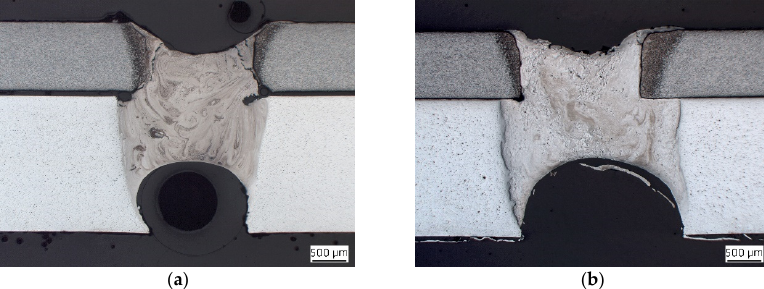
Figure 19. Comparison between the results of the displacement process at 1936 W magnet power after 100 ms ( a ) and 200 ms ( b ). 100 ms ( a ) and 200 ms ( b